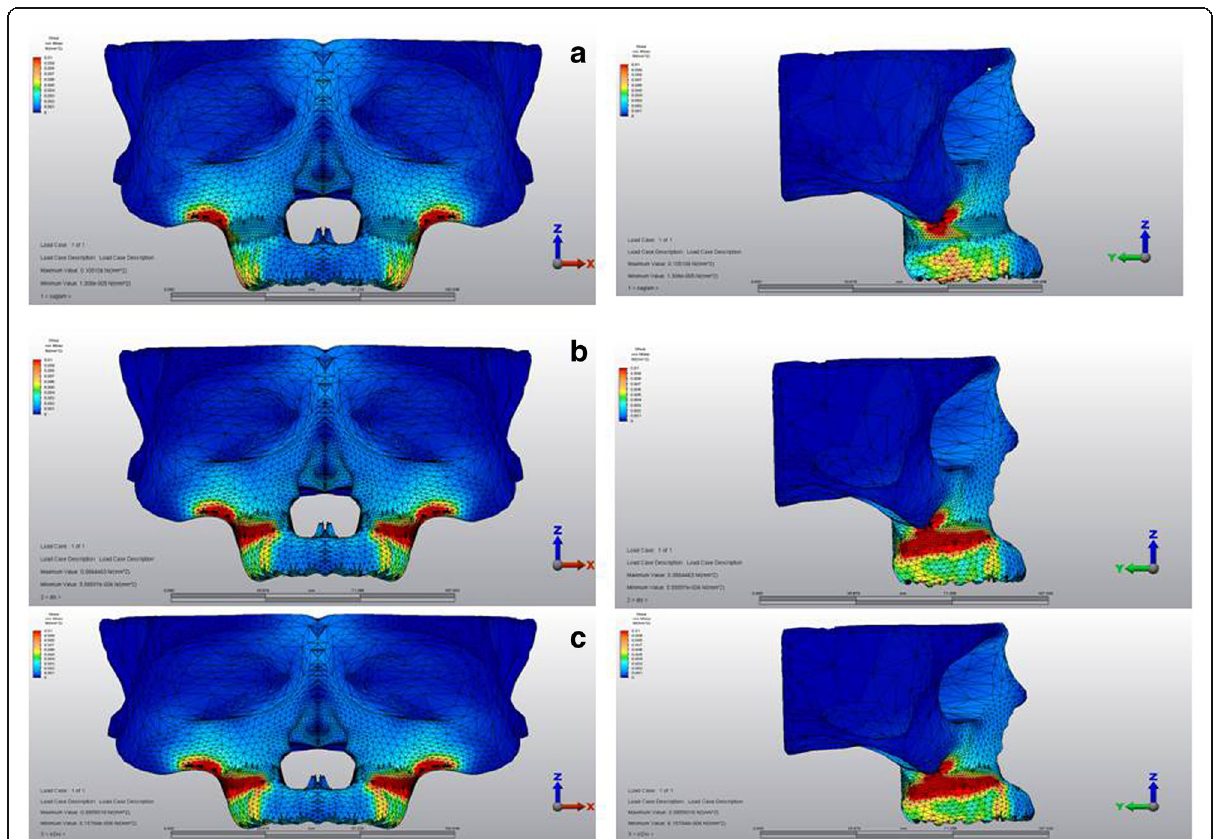
Fig. 5 Stress distributions over cancellous bone a first, b second, and c third